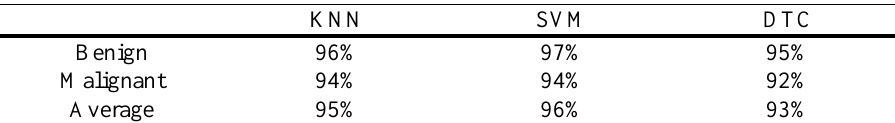
Table 3. Precision values of classifiers.